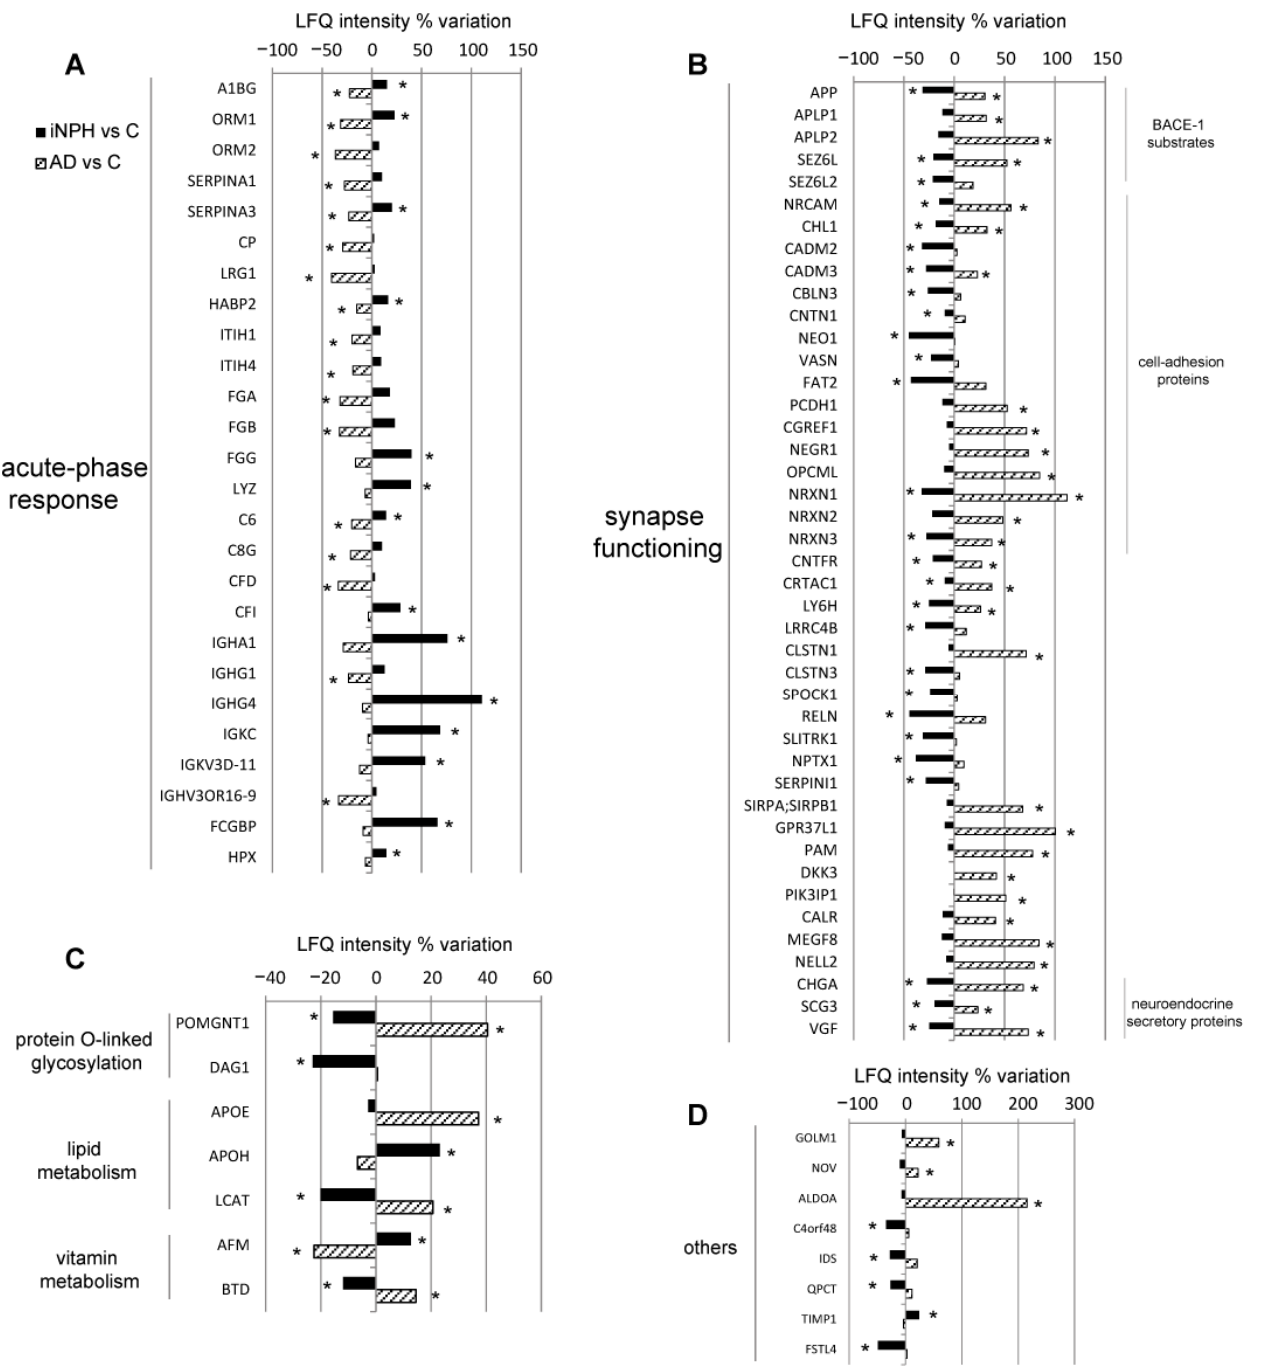
Figure 4. Differentially expressed CSF proteins in iNPH (black bars) and in AD (striped bars) patients compared to healthy cognitive subjects. Histograms of proteins with opposite trend levels in iNPH and AD (LFQ intensity% variation, * p -value < 0.05). Proteins were divided into panels according to their function. ( A ) acute phase response proteins. Alpha- 1B-glycoprotein (A1BG), alpha-1-acid glycoprotein 1 (ORM1), alpha-1-antichymotrypsin (SERPINA3), hyaluronan binding protein 2 (HABP2), fibrinogen gamma chain (FGG), lysozyme (LYZ) and hemopexin (HPX) complement component C6 and complement factor I (CFI), heavy constant alpha 1 (IGHA1), immunoglobulin heavy constant gamma 4 (IGHG4), immunoglobulin kappa constant (IGKC), immunoglobulin kappa variable 3D-11 (IGKV3D-11) and Fc fragment of IgG binding protein (FCGBP) were increased in iNPH. A1BG, ORM1, SERPINA3, HABP2, C6 levels, as well as alpha-1-acid glycoprotein 2 (ORM2), alpha-1-antitrypsin (SERPINA1), ceruloplasmin (CP), Leucine-rich alpha-2-glycoprotein